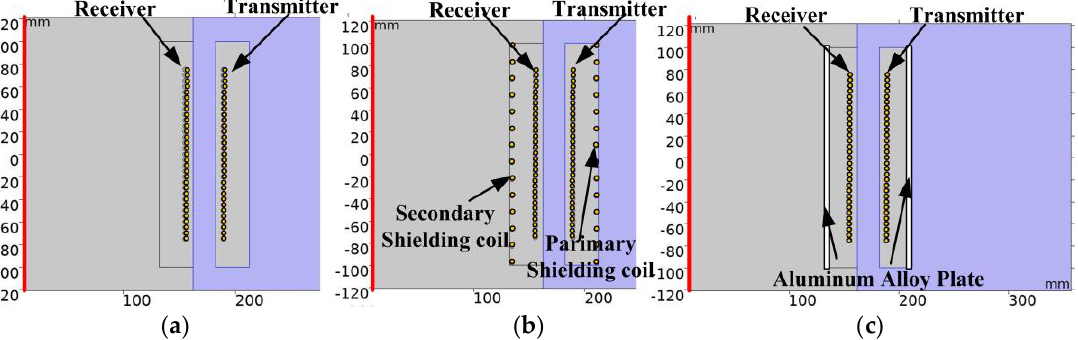
Figure 5. Simulation geometric models for WPT systems where the blue purple area means seawater, gray area is air, the white is aluminum alloy plate, coils are made of copper and the red lines are the rotary axis. ( a ) The underwater WPT system without shield. ( b ) The underwater WPT system with shielding coils. ( c ) The underwater WPT system with metallic plates as shield. Table 1. The meanings and value of parameters in the simulation.